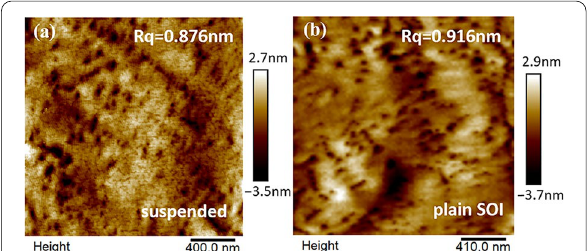
Fig. 3 AFM image of GaN surface on a effectively suspended zone in the suspended sample, b plain SOI sample